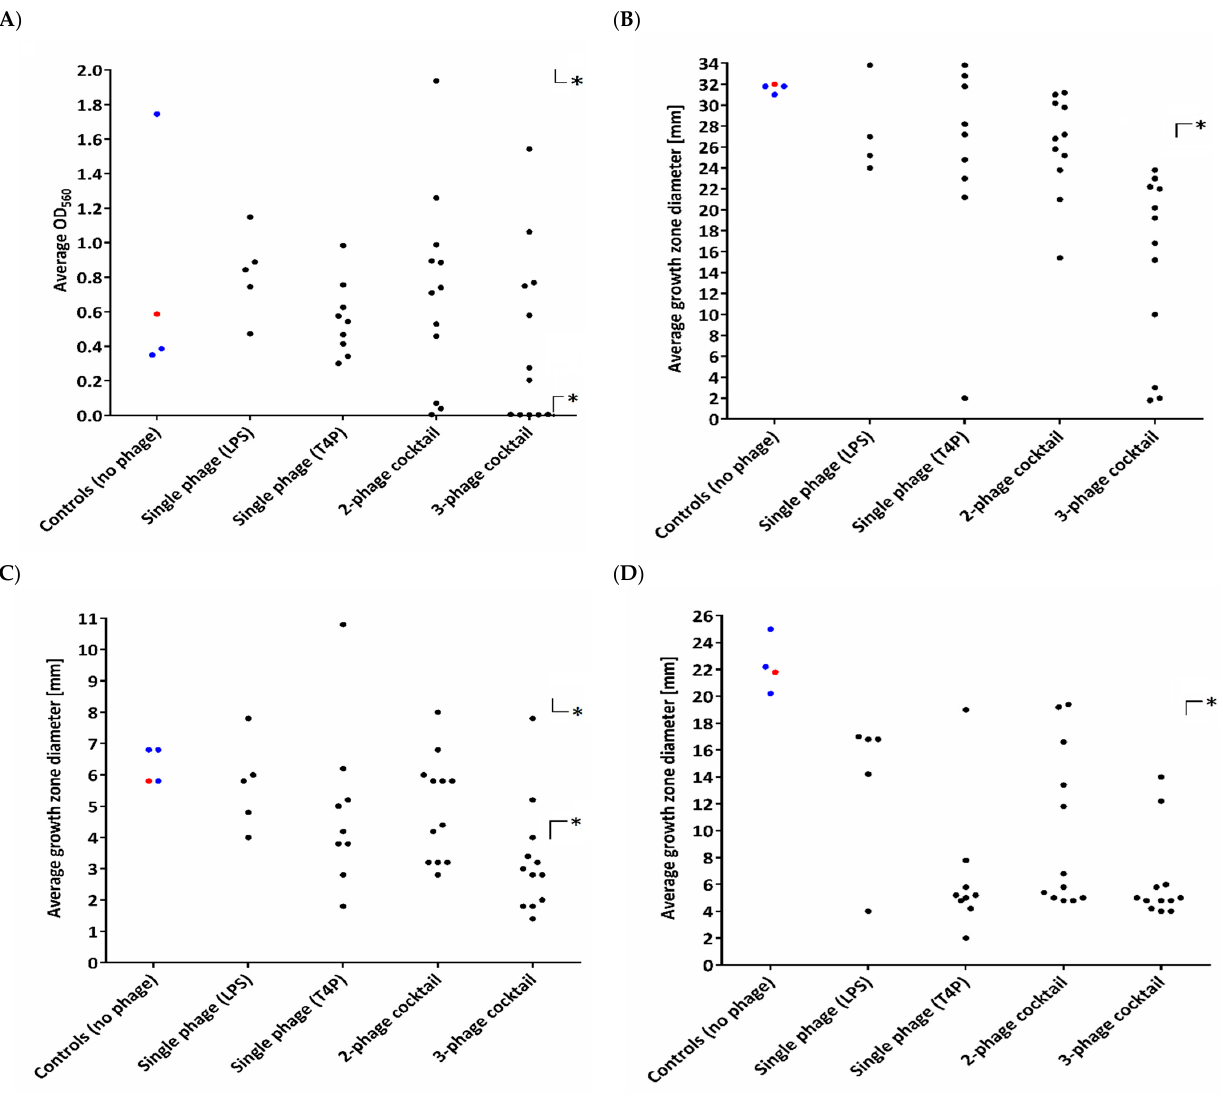
Figure 2. Changes in the biofilm formation ability and motility factors in the emerging phage-resistant PAO1 clones versus wild-type PAO1 sessile population: ( A ) biofilm formation; ( B ) swimming; ( C ) swarming; ( D ) twitching. Untreated sessile PAO1 was used as a control. The dots represent the measured values of the particular clones: wild-type clones (red dot); control sessile clones (blue dots); selected mutant phages (black dots). Statistically significant difference, compared to the phage-untreated pool (* p < 0.001).